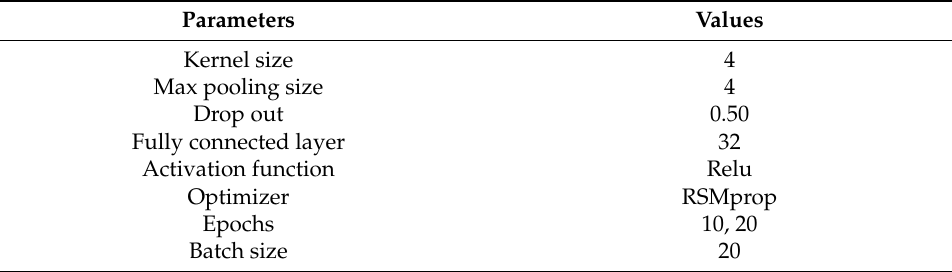
Figure 7. The structure of the LSTM technique. Table 1. Parameters of the LSTM